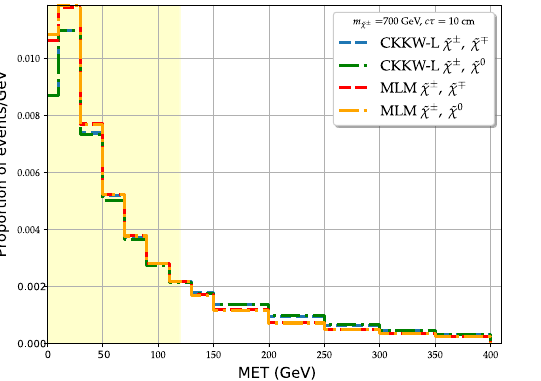
80% of ˜ χ ± ˜ χ ∓ events lie in the first bin, since the charginos are both escaping and being classed as muons, giving almost no missing energy. For ˜ χ ± ˜ χ 0 events the chargino nearly always escapes, leading to 40% of the events having MET larger than 400 GeV; the overflow bin is not shown